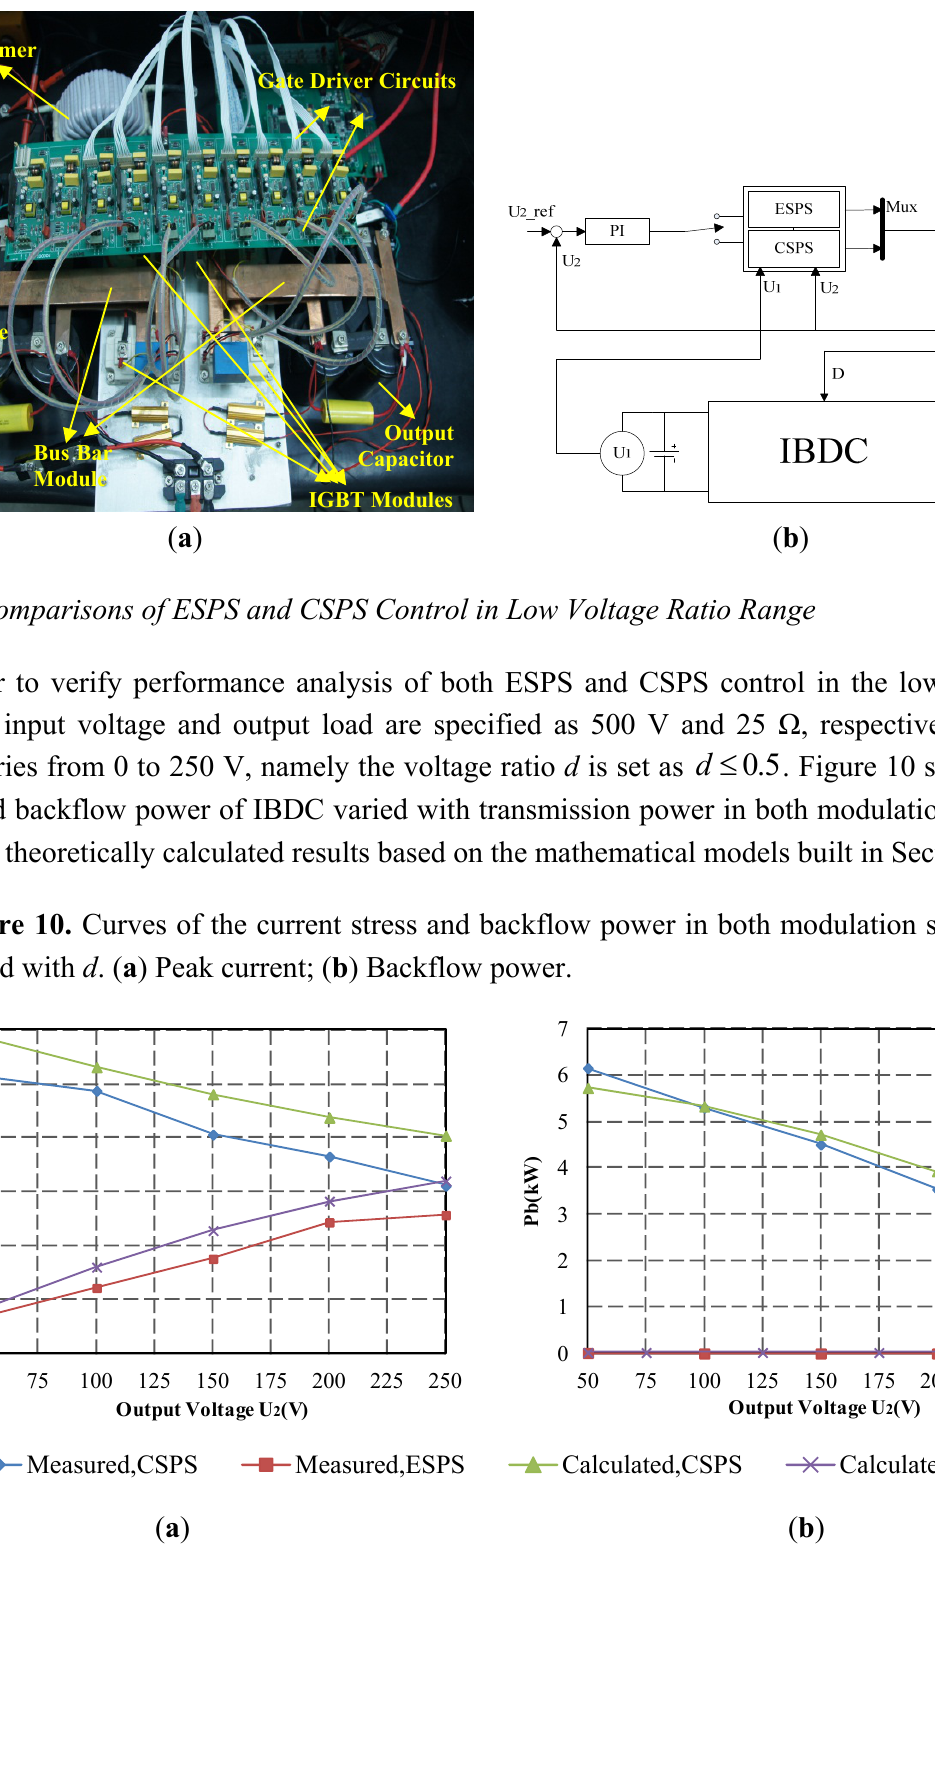
Figure 9. Photograph of the IBDC converter prototype and configuration of the converter .